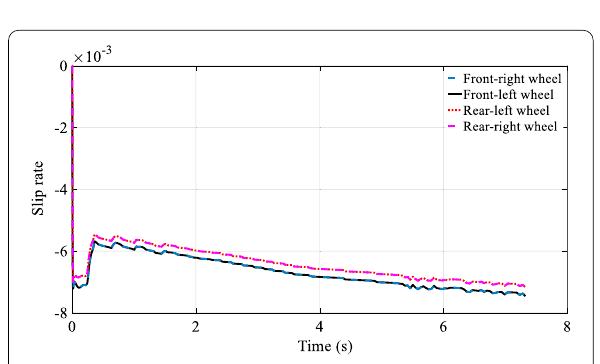
Figure 6 Slip rate of EVs by LTV-MPC